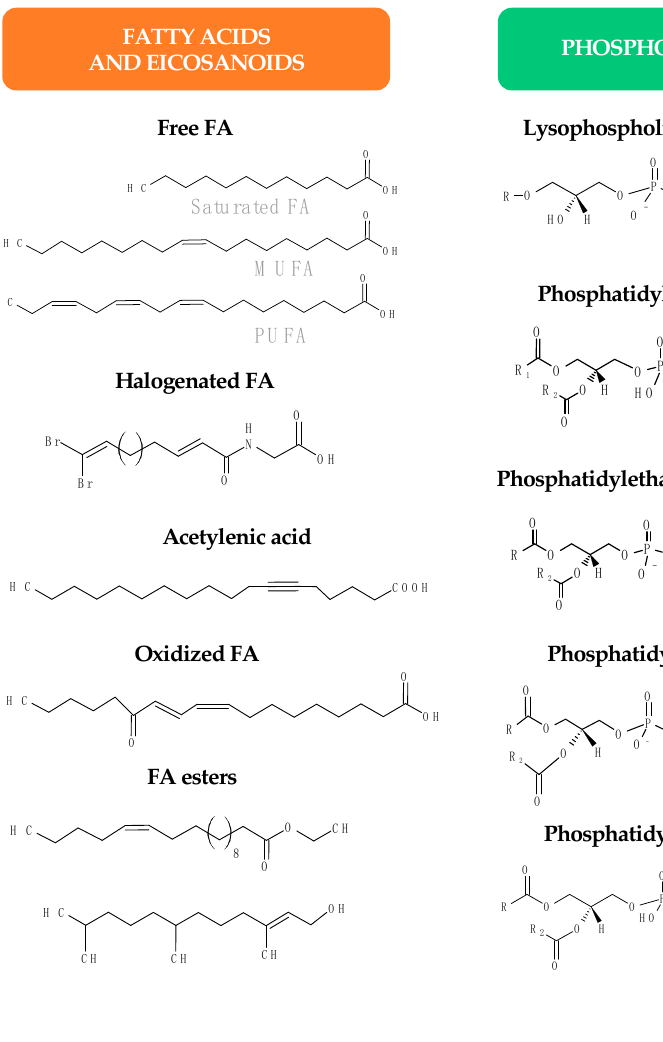
Figure 2. Chemical structures of the different lipid classes isolated from natural sources with antimicrobial activity. Figure 2.